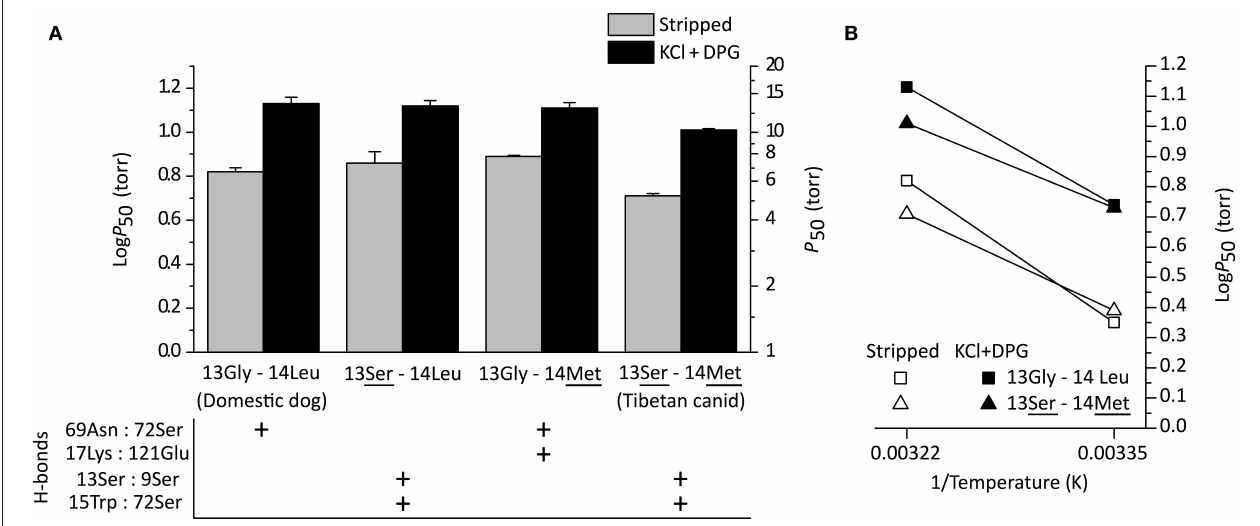
FIGURE 4 | Functional effects of amino acid replacements in Tibetan mastiff and Tibetan wolf Hb. (A) O 2 -affinities of recombinant Hbs representing the (ancestral) wildtype genotype of domestic dog/gray wolf (13Gly-14Leu), the derived, double-mutant genotype of Tibetan mastiff/Tibetan wolf (13 Ser -14 Met ), and each of the possible single-mutant genotypes (13 Ser -14Leu and 13Gly-14 Met ). P 50 -values ( ± SEM) are shown in the absence (“stripped”) and presence of allosteric effectors (“KCl + DPG”) at 37 ◦ C. The lower the P 50 , the higher the O 2 affinity. P 50 -values for the double-mutant (13 Ser -14 Met ) were significantly higher than those of the other three genotypes for both treatments (stripped and KCl + DPG). For each genotype, the panel below denotes the presence and absence of key hydrogen bonds in the β -chain subunit. (B) van’t Hoff plot of rHbs representing wildtype genotypes of domestic dog/gray wolf (13Gly-14Leu) and Tibetan mastiff/Tibetan wolf (13 Ser -14 Met ) derived from O 2 -equilibrium curves measured at 25 and 37 ◦ C. Reproduced from Signore et al. (2019).